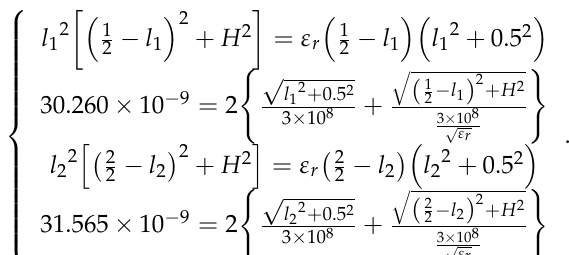
Table 2. Simulation parametersof the experiment models.